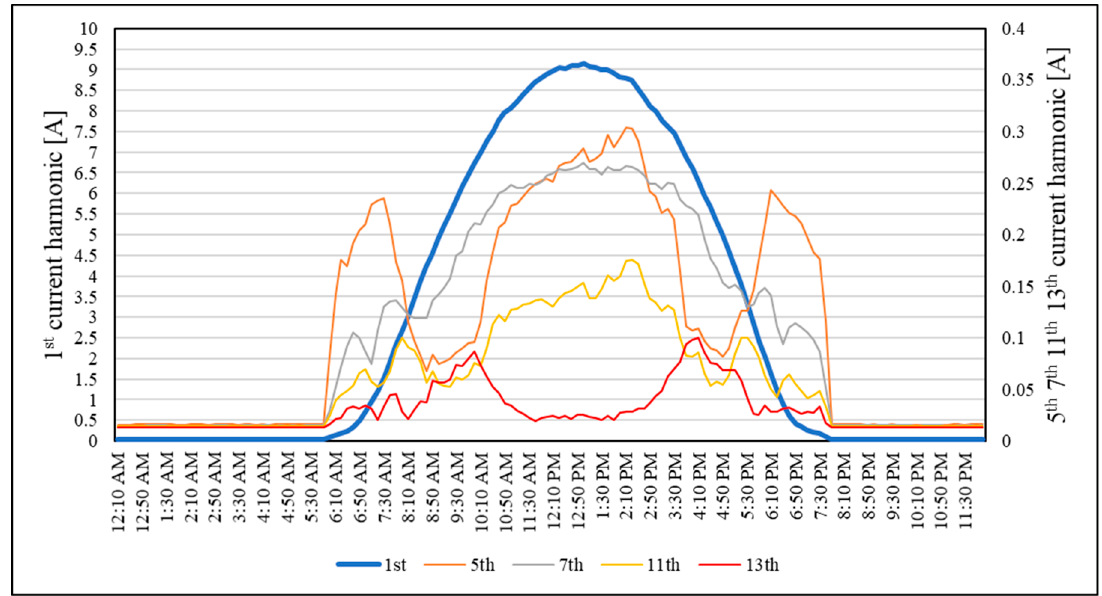
Figure 4. Effective current values of the 1st, 5th, 7th, 11th, and 13th current harmonics during a sunny day (21 August 2018).